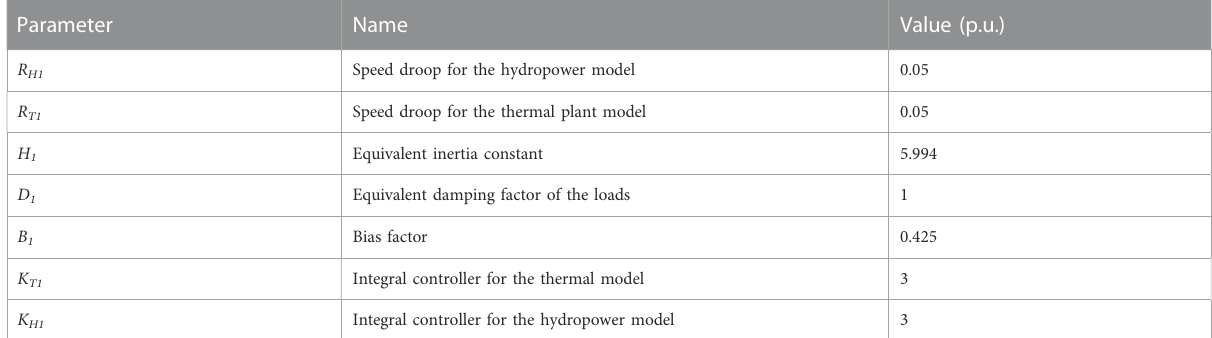
TABLE 1 Parameters for the frequency regulation model.